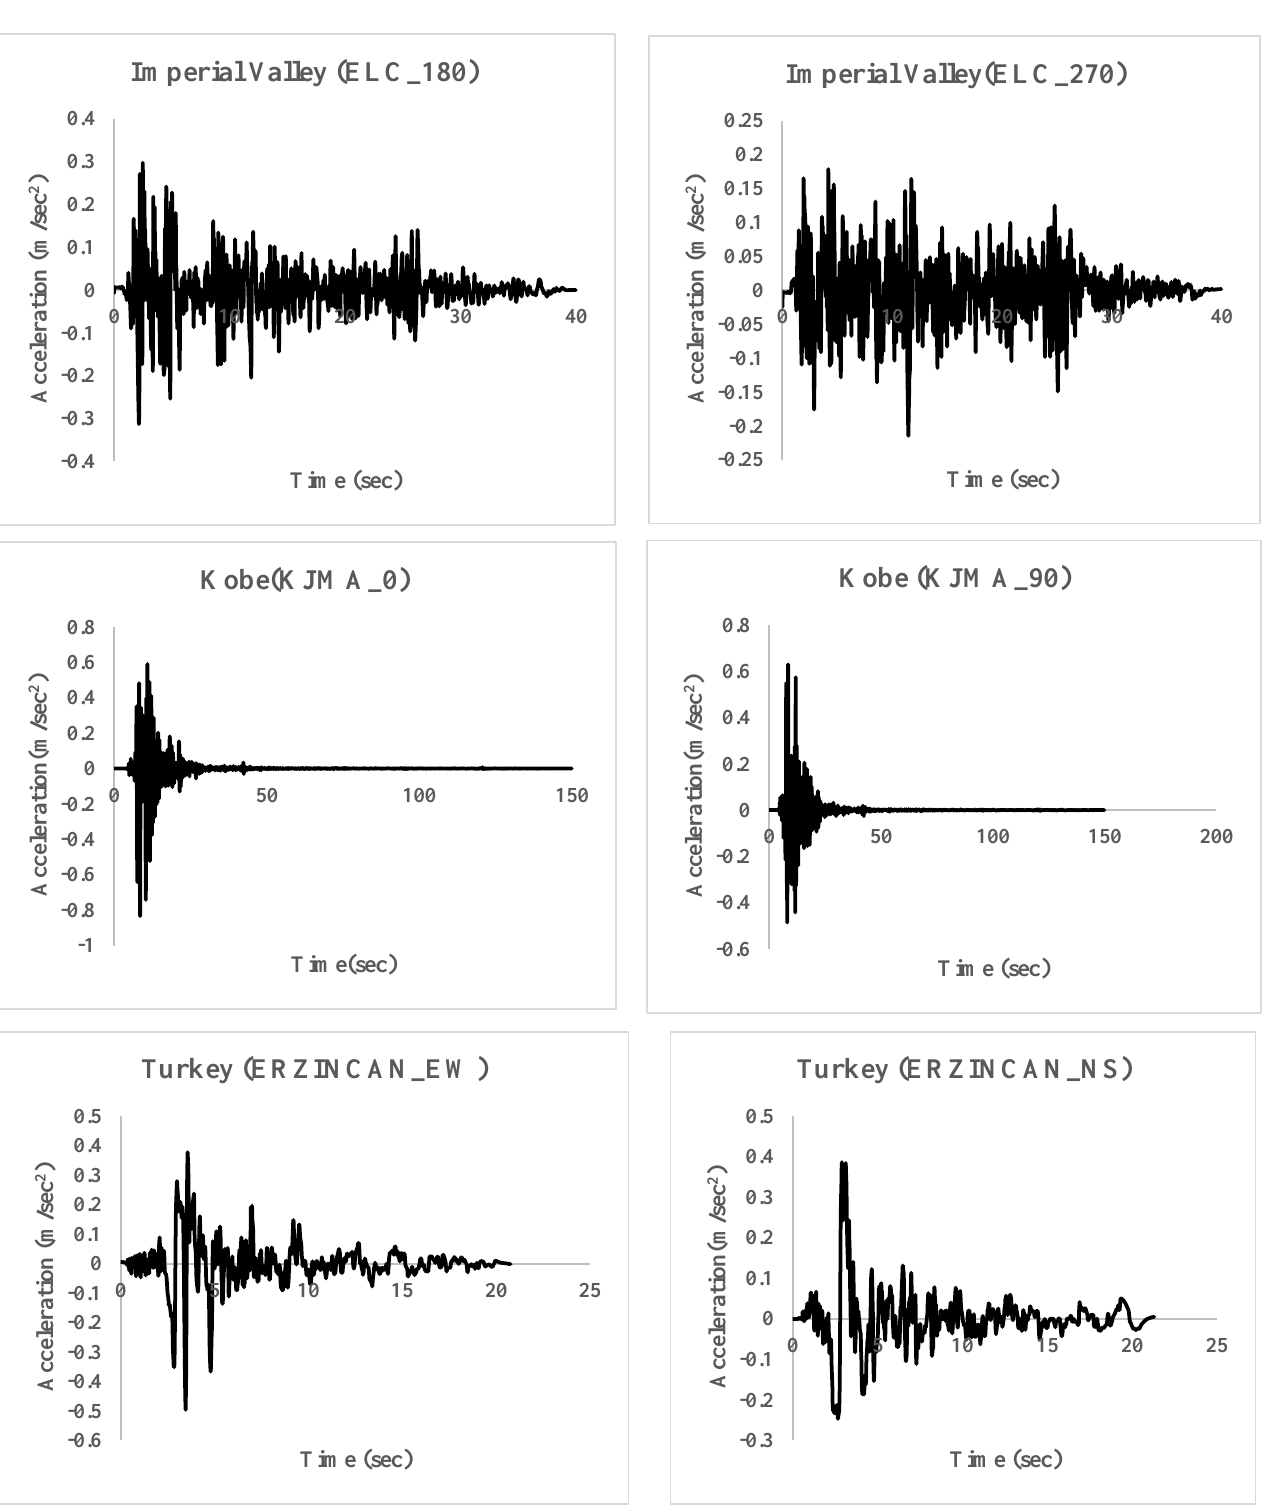
Figure 6. Response spectrum of Imperial Valley (IV), Kobe, and Turkey ground motions . 4. Effect of Incidence Angle The earthquake’s incident angle (α) is an important consideration because the bridge is of a curved configuration and the contribution of responses from both horizontal direc- tions is vital for the bearing design. This study considered the key response parameters, such as deck acceleration, bearing displacement, force transmitted to the pier, and pier torsional moment. Figure 7a – l depict the bridge response to the uni-directional ground motion for the Imperial Valley, Kobe, and Turkey earthquakes, with incident angles ranging from 0° to 90°. It was observed that the variations of response parameters with respect to the earth- quake incidence angle were non-linear. For all the considered ground motions, the change in bearing displacement was small (up to 5%). The maximum deck acceleration is de- creased for all the motions, especially between 45° and 67.5°. The maximum reduction of deck acceleration was observed for Kobe ground motion (about 13.16%). The variation of force transmitted to the pier was small (0 – 4%) for the Imperial Valley and Kobe earth- quakes. In the case of the Turkey earthquake, however, the force transmitted to the pier was reduced by about 8%. The variation of the pier torsional moment was almost negligi- ble in the Imperial Valley earthquake, whereas the variations were different for other ground motions. In the case of the Kobe earthquake, the maximum reduction of pier